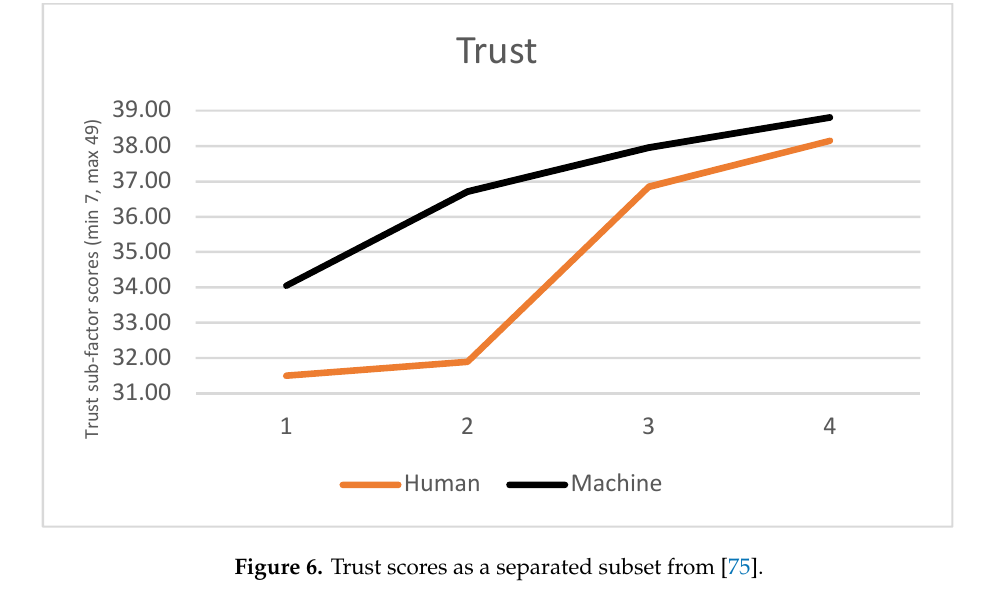
Figure 5. Distrust scores as a separated subset from [75]. 304